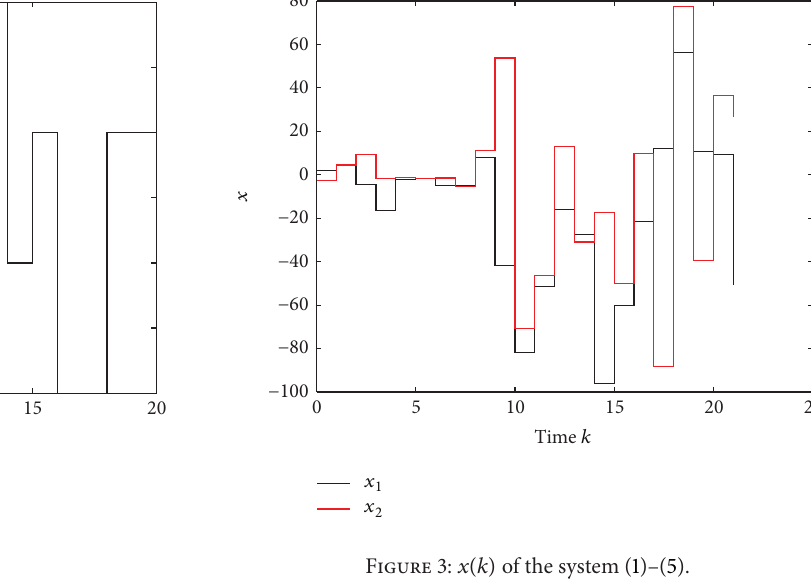
Figure 2: 𝑟 𝑘 of jump rates.